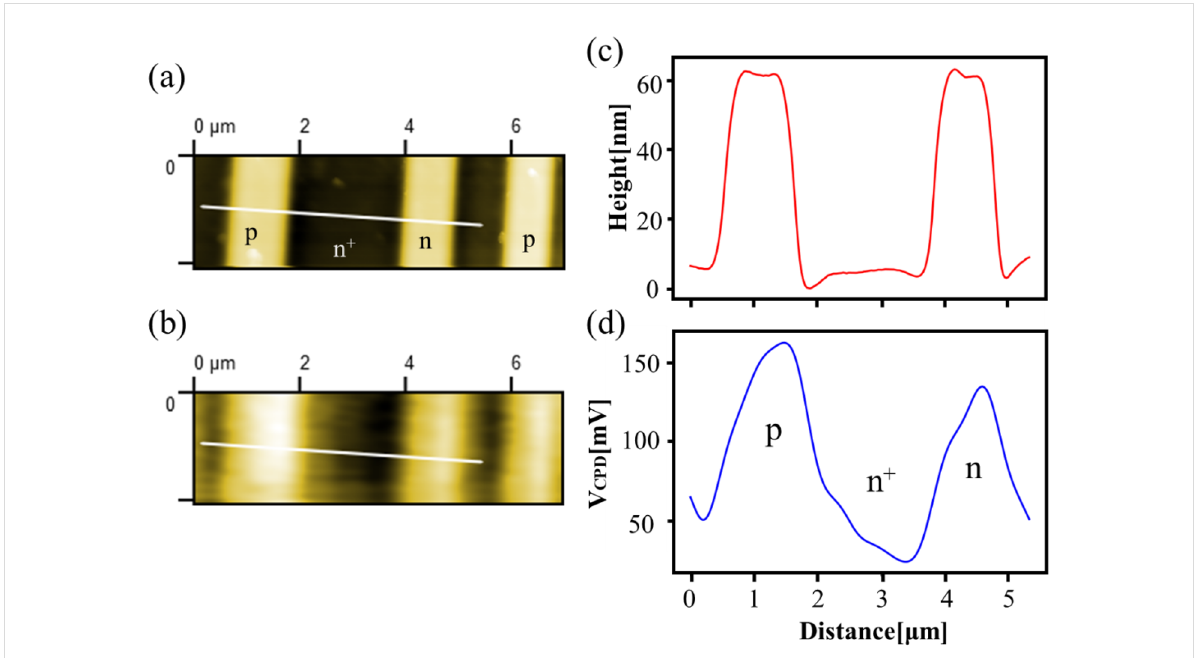
Figure 6: (a) Surface topography and (b) CPD image of the pn-patterned Si surface. The CPD image was obtained by KPFM using an AC bias voltage with a low modulation frequency of f m = 100 Hz. The scan size was 7 μ m × 2.1 μ m. (c) Line profile corresponding to the white line in panel (a); (d) line profile corresponding to the white line in panel (b).